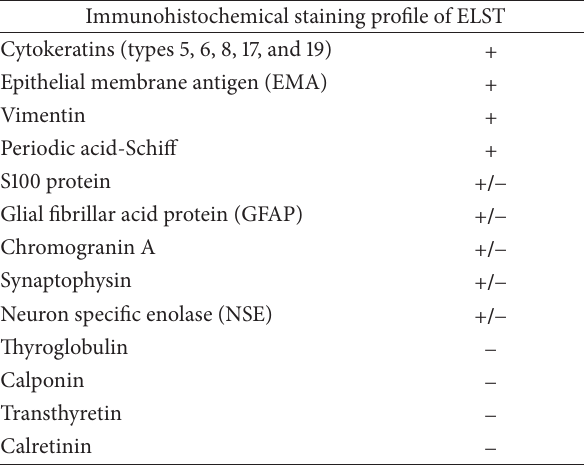
Table 1: Immunohistochemical staining profile of ELST. Immunohistochemical staining profile of ELST Cytokeratins (types 5, 6, 8, 17, and